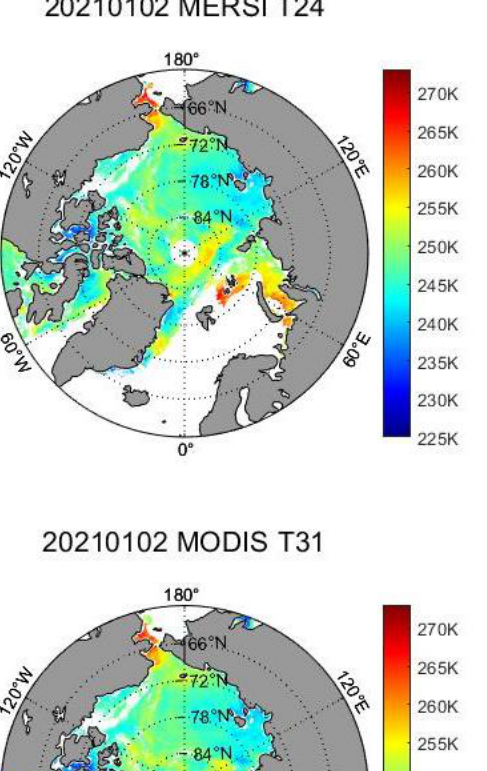
Figure 4. Comparison of distribution maps of MERSI (channels 24 and 25) and MODIS (channels 31 and 32) daily average thermal infrared T b data on 2 January 2021.